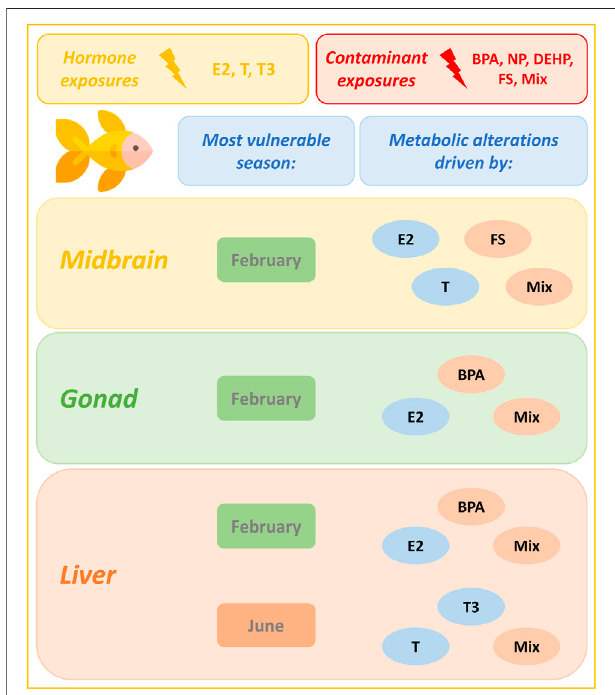
FIGURE 7 | Seasonal dependence of male gold fi sh to metabolic alterations induced by hormone and contaminant exposures. This fi gure models seasonal dependence of male gold fi sh to metabolic alterations induced by hormone and contaminant exposures across growth and reproductive stages. In all tissues analyzed, February is observed to be a period of enhanced vulnerability to metabolic alteration. An additional window of susceptibility is observed in liver in June. Hormones and contaminants contributing most extensively to biochemical pathway alterations in a particular tissue and season are highlighted. Results are based on the Metabolite Set Enrichment Analysis (MSEA). The gold fi sh icon used in this fi gure was made by Freepik (www.freepik.com) from www. fl aticon.com.